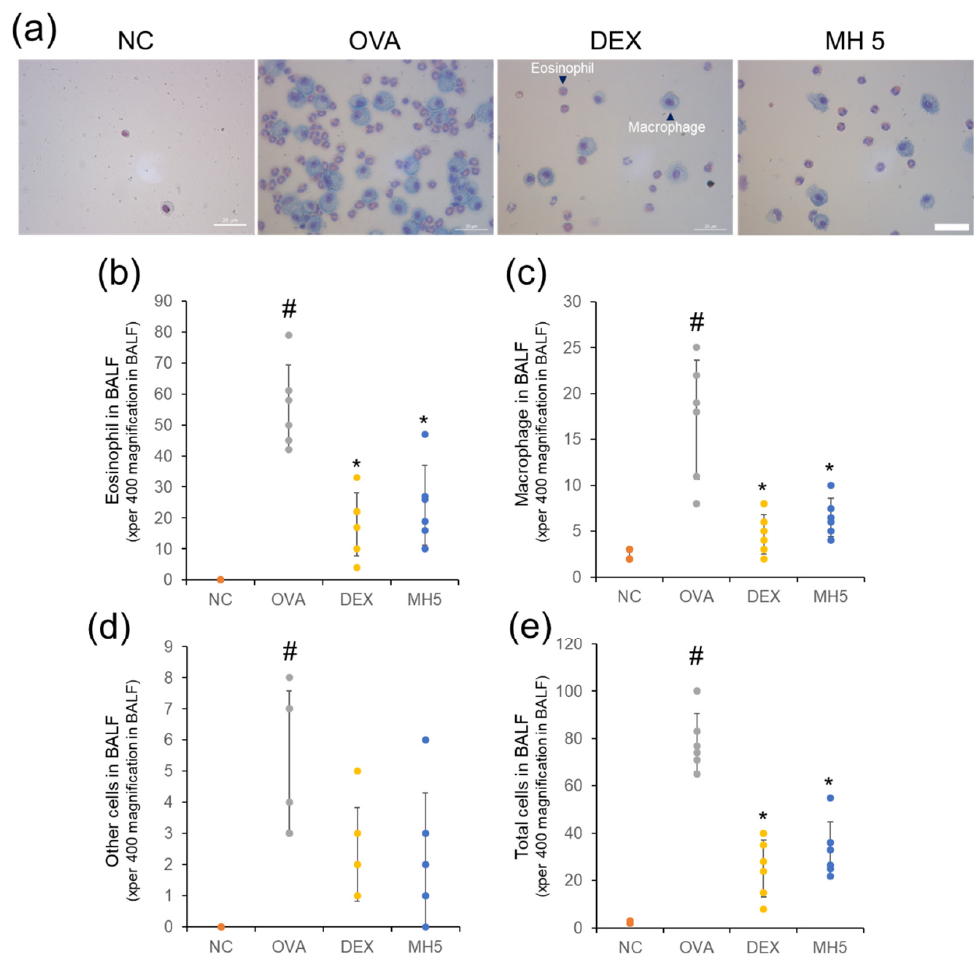
Figure 6. Effects of MH on recruitment of eosinophils and macrophages in mice with AA. ( a ) Microscope images of immune cells (magnification, ×400; scale bar, 25 μ m). ( b – e ) The numbers of immune cells in BALF were determined using cell counting. NC: normal control mice; OVA: OVA-sensitized/challenged mice; DEX: 1 mg/kg DEX-treated OVA mice; and MH 5: 5 mg/kg MH-treated OVA mice group. Data are expressed as the mean ± SD (n = 6) ( # p < 0.05 for comparison with normal control; * p < 0.05 for comparison with OVA group).